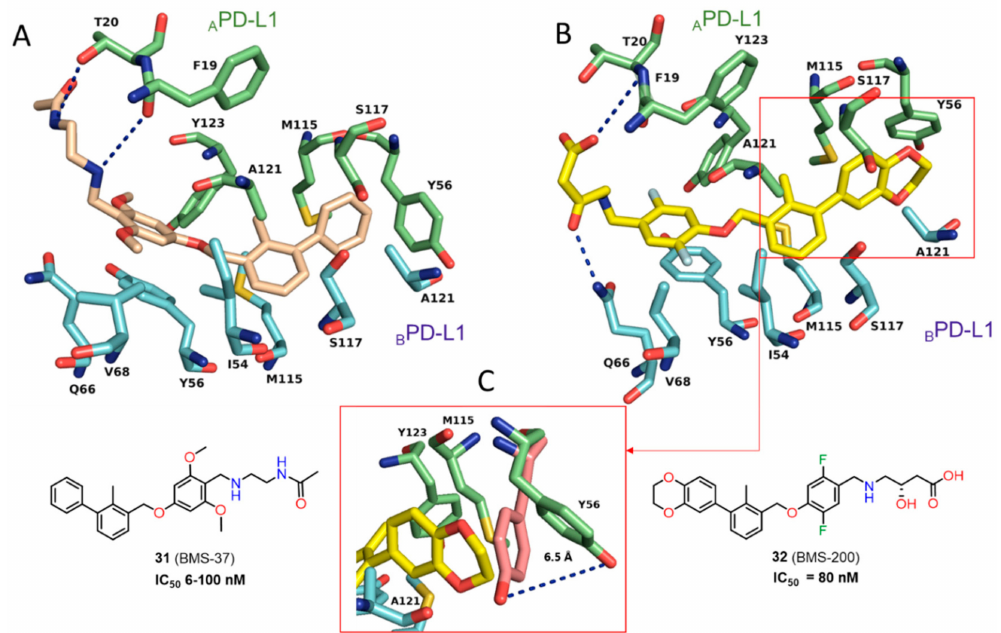
Figure 15. ( A ) Detailed interactions of 31 (light yellow) at the binding cleft of PD-L1. Compound 31 binds at a hydrophobic cavity formed upon PD-L1 binding. ( B ) Detailed interactions of 32 (yellow) at the binding cleft of PD-L1. 32 binds at a hydrophobic tunnel formed upon the PD-L1 dimerization. The movement of the aromatic ring of A Tyr56 is induced by the 2,3-dihydro-1,4-benzdioxine moiety. ( C ) The movement of A Tyr56 (green) that is induced by the 2,3-dihydro-1,4-benzdioxine group of 32 (yellow) compared with the A Tyr56 (salmon) arrangement in the complex of 31 /